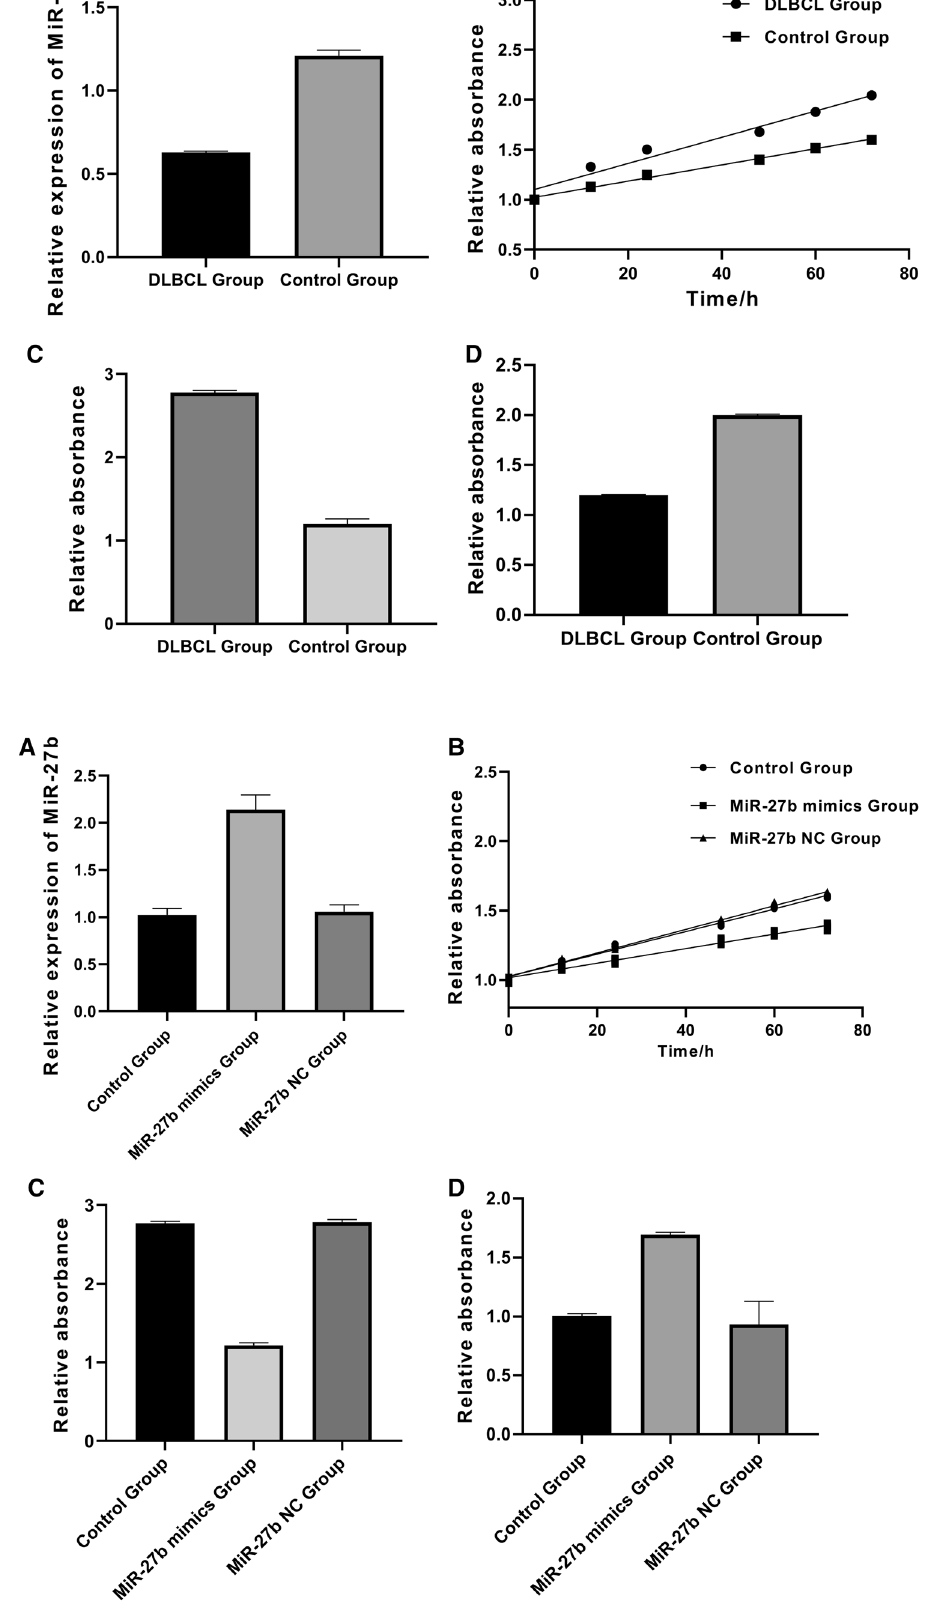
Fig. 2 Low miR-27b expres- sion was associated with high proliferation and high invasiveness of DLBCL cells.